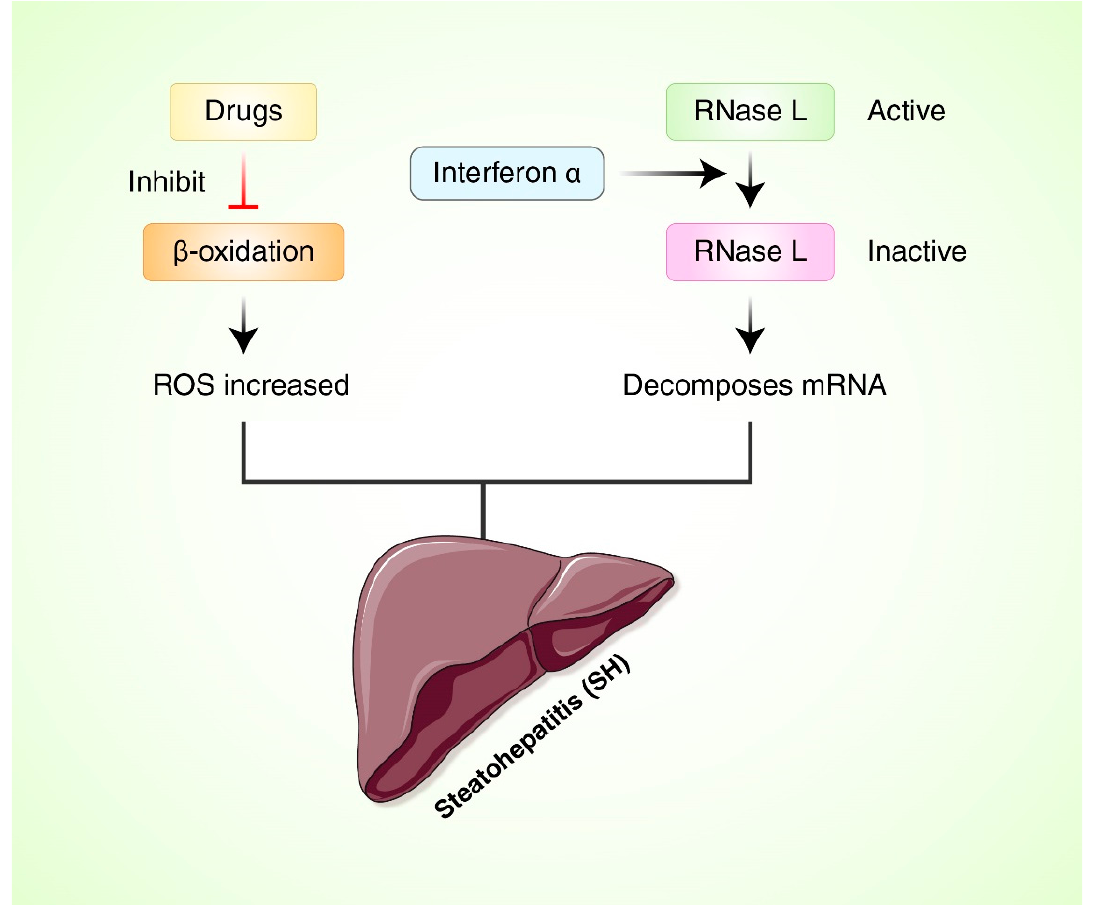
Figure 6. Drug target to reduce oxidative stress in liver damage. Ribonuclease L (RNase L), interferin.